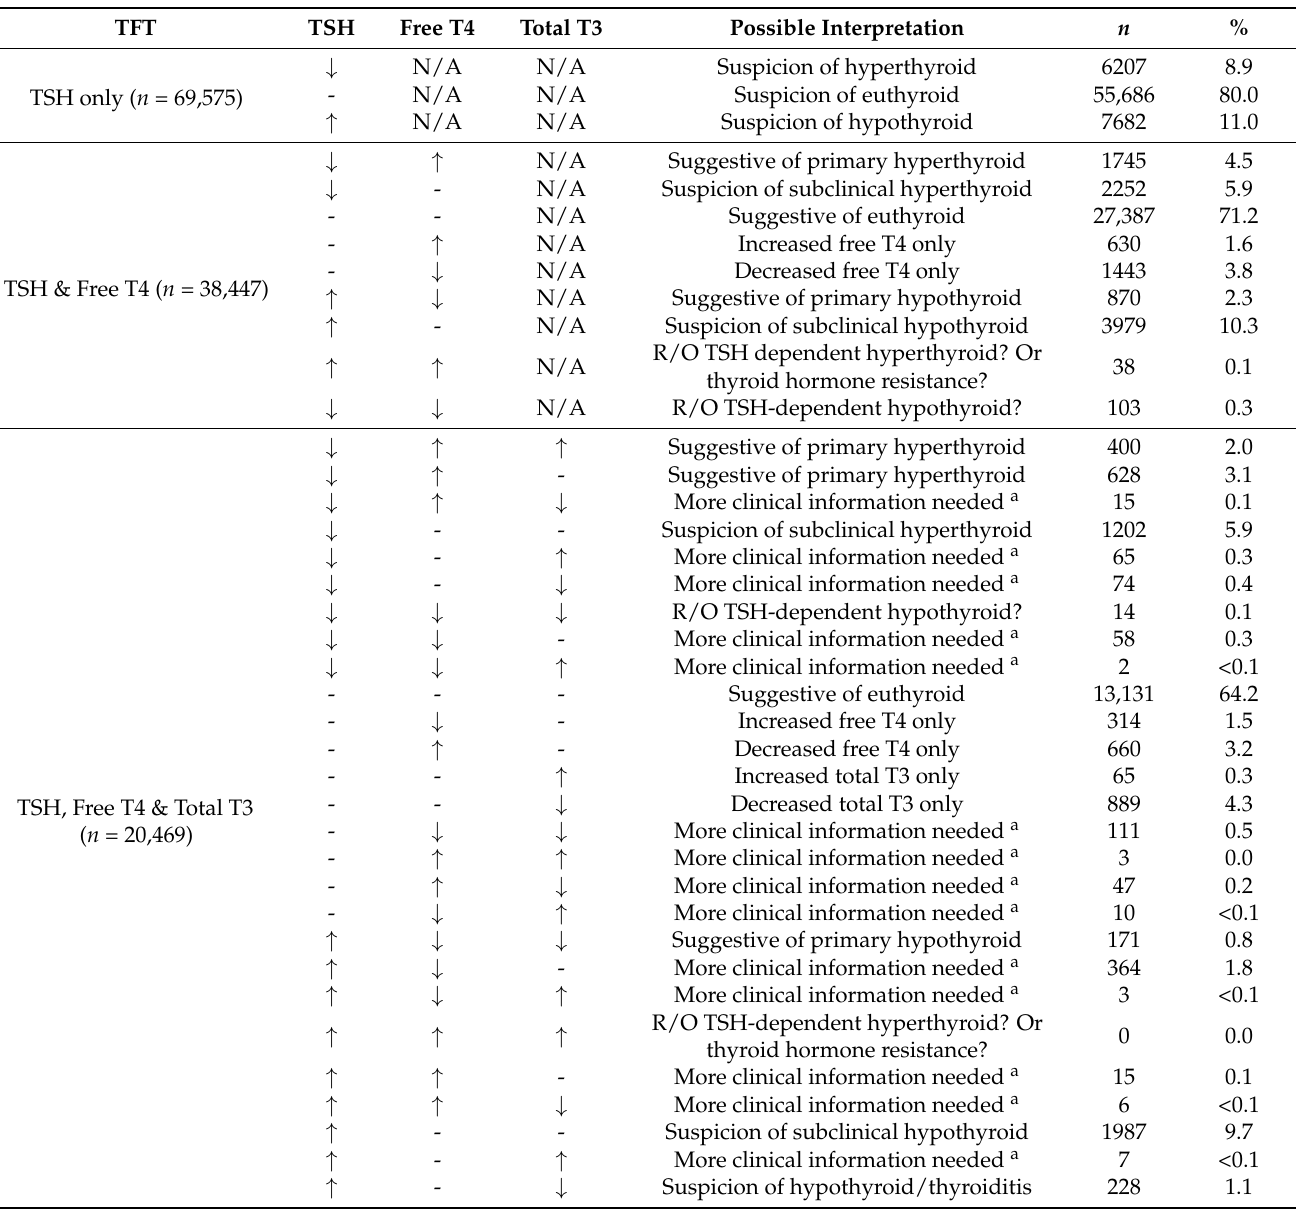
Table 2. Prevalence of thyroid function test